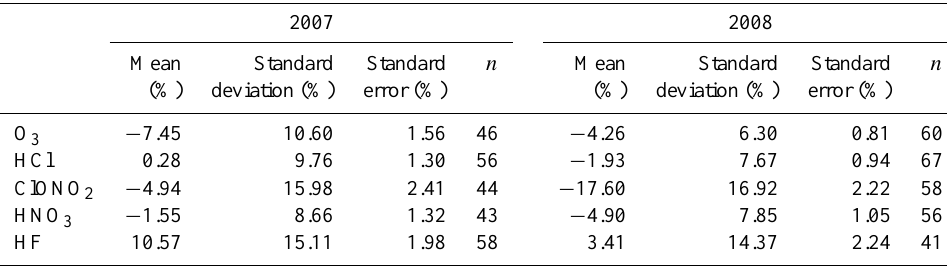
Fig. 4. Same as Fig. 1, with 125HR and DA8 smoothed to match the PARIS-IR resolution. Comparison statistics are given in Table 2. Table 3. Mean percentage differences between ACE-FTS and 125HR partial columns (calculated as described in the text), one standard √ n ), and the number of pairs of measurements deviation from the mean (also as a percentage), standard error on the mean (standard deviation/ ( n ) used in these calculations, for both 2007 and 2008. Note that the partial column altitude ranges varied for each individual comparison, but were typically around 6–43km (O 3 ), 8–38km (HCl), 15–26km (ClONO 2 ), 8–29km (HNO 3 ) and 10–43km